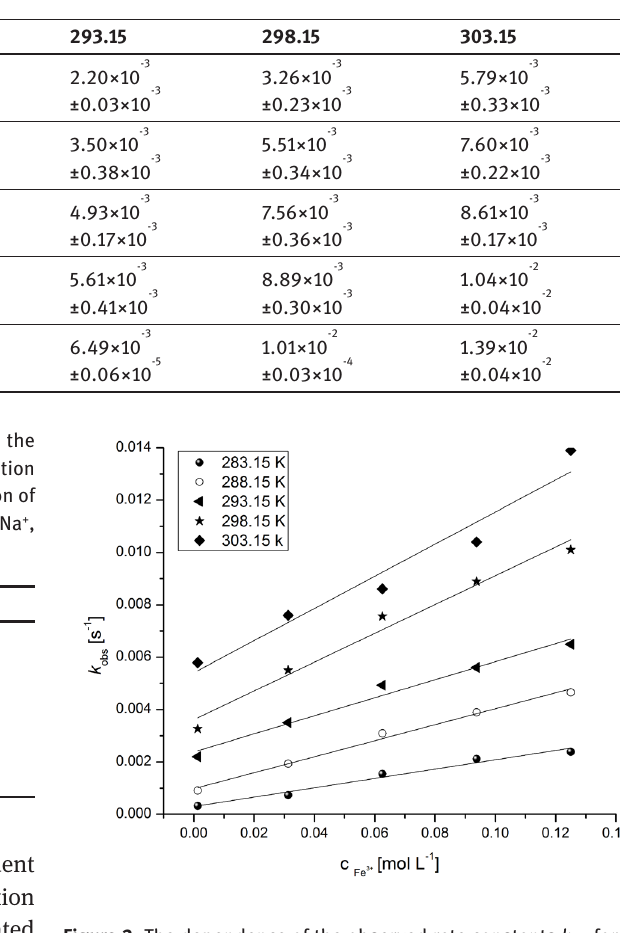
Figure 2 . The dependence of the observed rate constants k aquation reaction at five temperatures. The concentration of [Co(ODA) (H O) ] = 4×10 -3 M, [H O] + = const. = 0.15 M, ionic strength (Na + , NO 3- ) 2 3 3 I = 1.0 M.